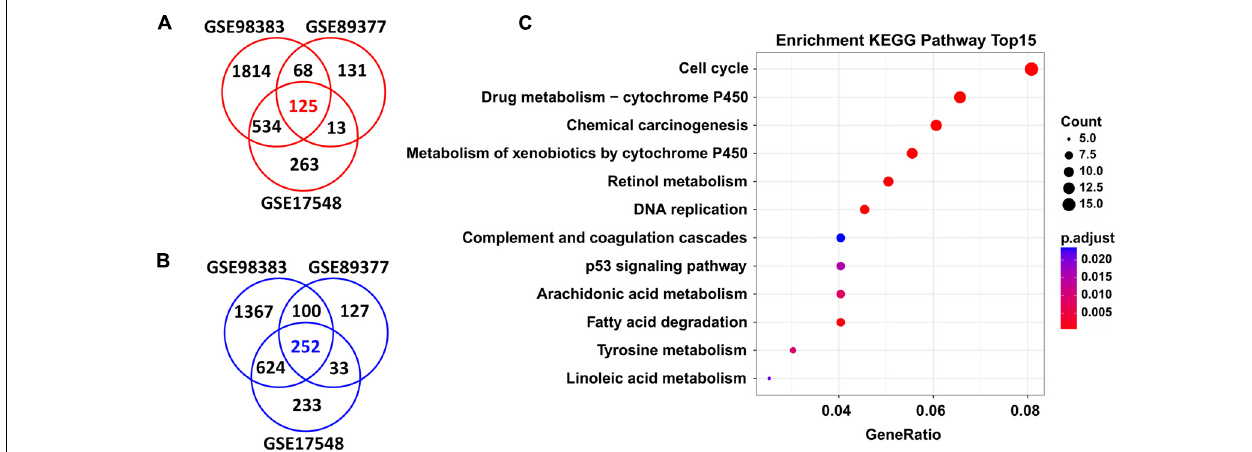
FIGURE 2 | DEGs shared in three independent microarray datasets and their potential functions. A total of 125 upregulated genes (A) and 252 downregulated genes (B) were shared between the GSE98383, GSE89377, and GSE17548 datasets when comparing HCC to cirrhosis subjects. Red indicates upregulation and blue represents downregulation. DEGs were determined using GEO2R software. FDR < 0.05 and FC > 1.5 were considered as the cutoff values. (C) Significantly enriched KEGG pathways of the total shared DEGs. ClusterProfiler package was selected to perform KEGG pathway enrichment analysis. Adjusted P -values of < 0.05 were considered statistically